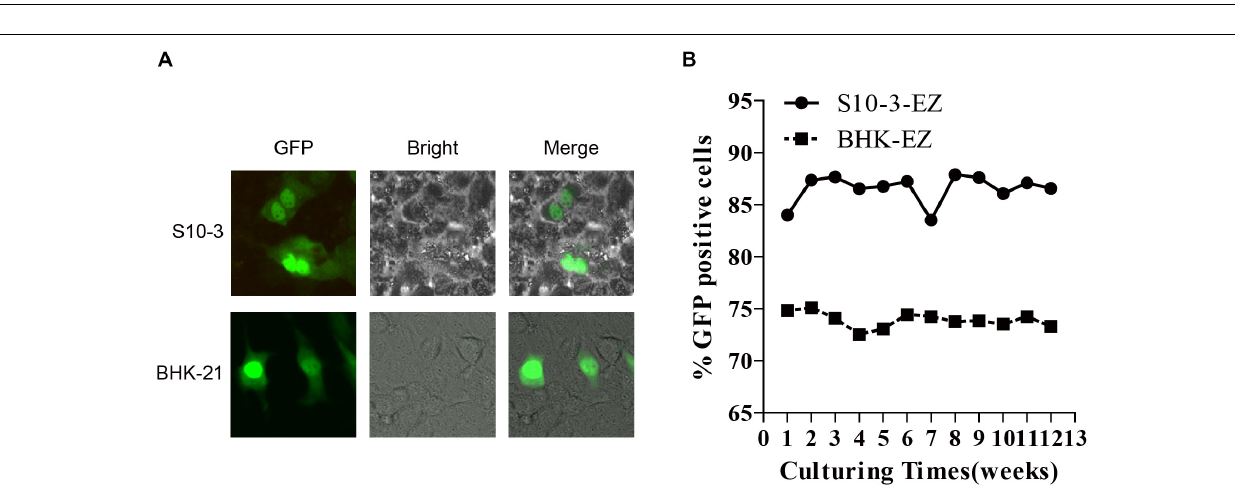
FIGURE 3 | Stable and continuous expression of HEV RNA in persistent HEV replicon cell lines BHK-EZ and S10-3-EZ. (A) Total RNAs extracted from BHK-EZ and S10-3-EZ cells were used to transfect naïve BHK-21 and S10-3, resulting in green fluorescence signals that indicate the existence of replicating HEV genomes in cells in the form of RNA, and does not integrate into the host cell genome. (B) Detection of HEV replicon stability in the two cell lines by